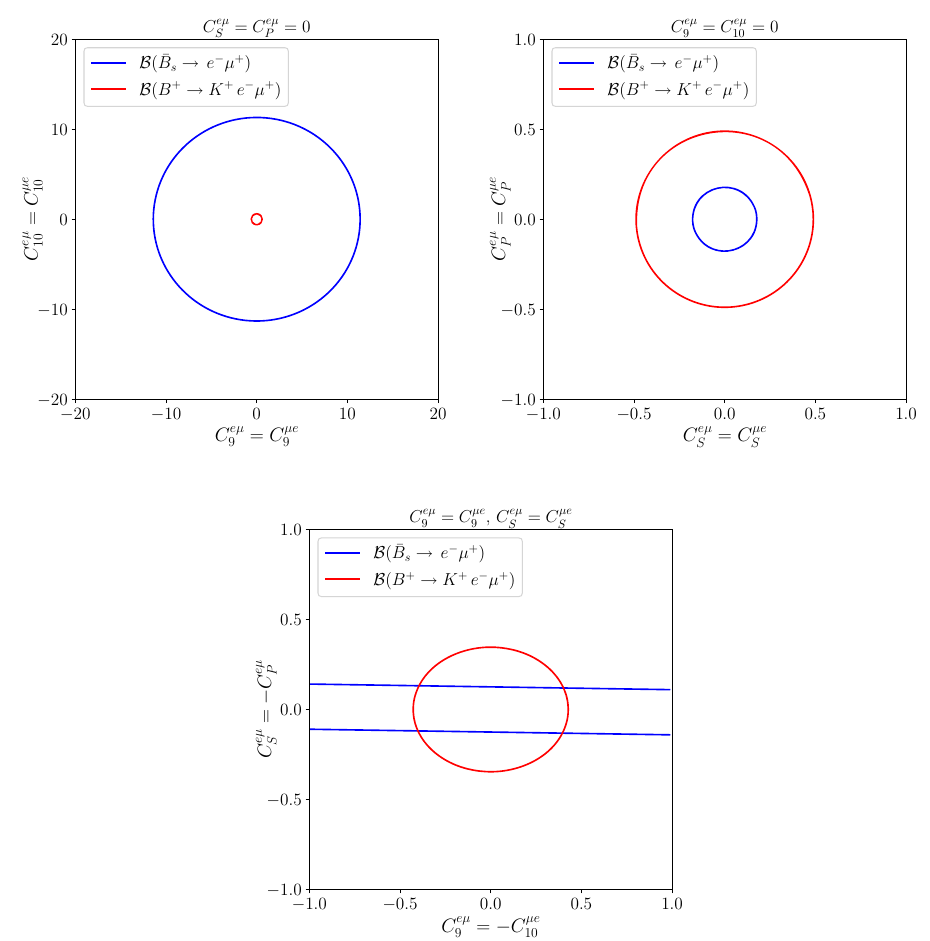
Fig. 2 Model independent constrains on different combinations of Wilson coefficients obtained from the 90% CL upper limits on meson b → s μ ± e ∓ transitions in Fig. 1, we find large differences between the τ + μ − and the τ − μ + . Hence, we stress that it is important to analyse these final states separately. For the electron, the differences between μ − e + and μ + e − are negligible and we only present one